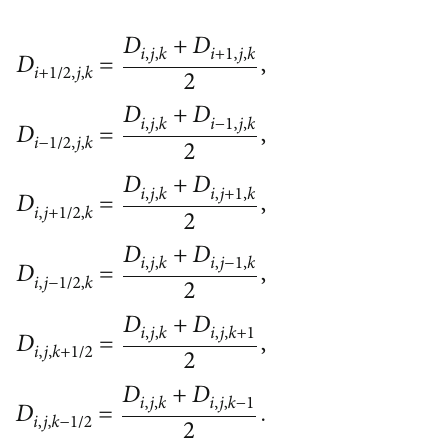
di ff erence method, the fi rst order central di ff erence of the variables x , y , and z were determined: